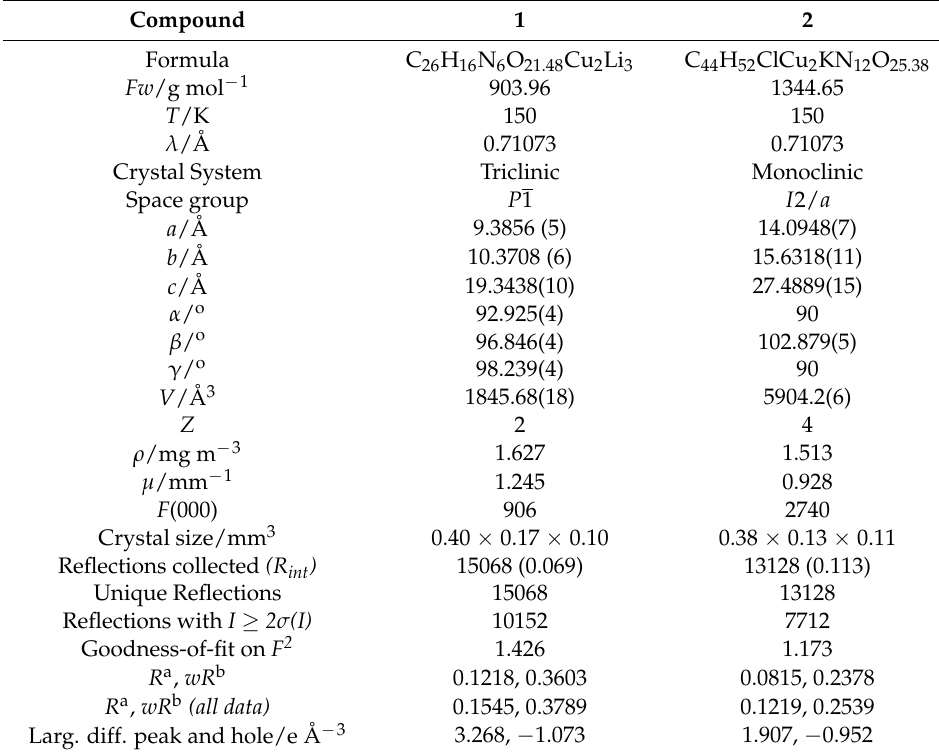
Table 1. Summary of Crystallographic Data for 1 and 2